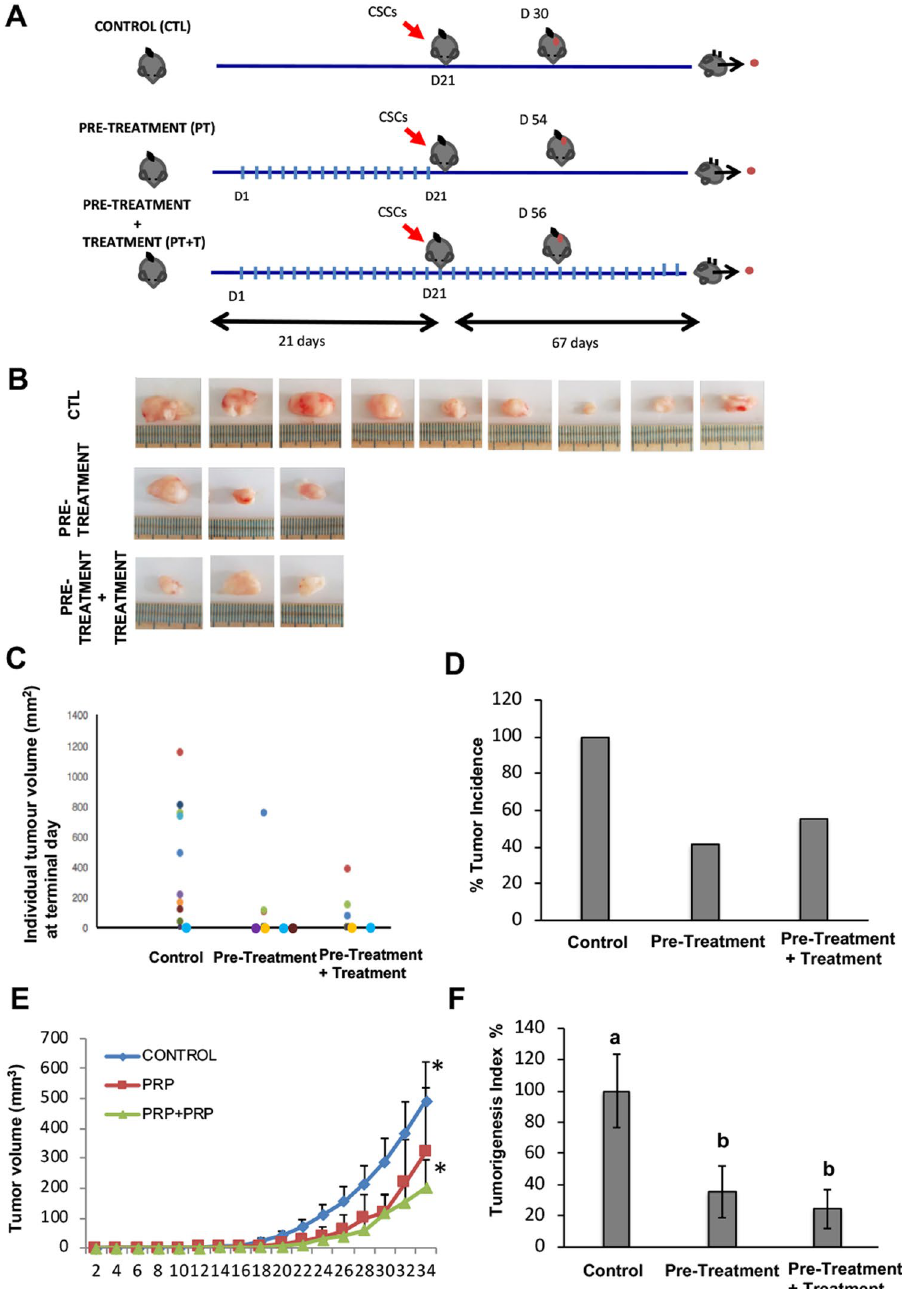
Figure 7. PRP reduced tumour growth of pancreatic CSCs in vivo . ( A ) Scheme of the in vivo study design to determine antitumour activity of PRP against pancreatic CSCs induced tumours. Perpendicular bars stand for PRP bolus injection. BxPC3 CSCs injection into the flank of nude mice is represented by a red arrow. ( B ) Photographs of the subcutaneous tumors isolated from mice included in the control and PRP treated groups at the end of the experimental protocol. ( C ) Tumour weight of each single tumour (different colour circles) at Termination (mg), mice with no tumour are represented by a colour circle on the X axis. ( D ) Tumour incidence. Percentage of mice with tumours respect to control group which represented a 100% of tumour incidence. ( E ) Tumour size evolution over time. MEM ± SE. * p < 0.05 vs. control group. ( F ) Tumorigenesis Index (TIn). This index relates tumour incidence and tumour weight. Percentage of mice with tumours respect to control group which represented a 100% of tumour incidence. Mean Tin ± SE at Termination. Different letters stand for significant differences (p <